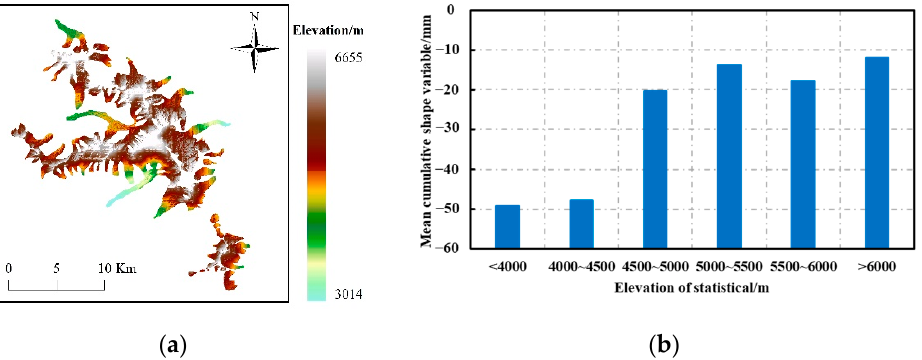
Figure 16. ( a ) Glacier elevation (m) in the study area. ( b ) Statistics of measured glacier deformation at different elevations.